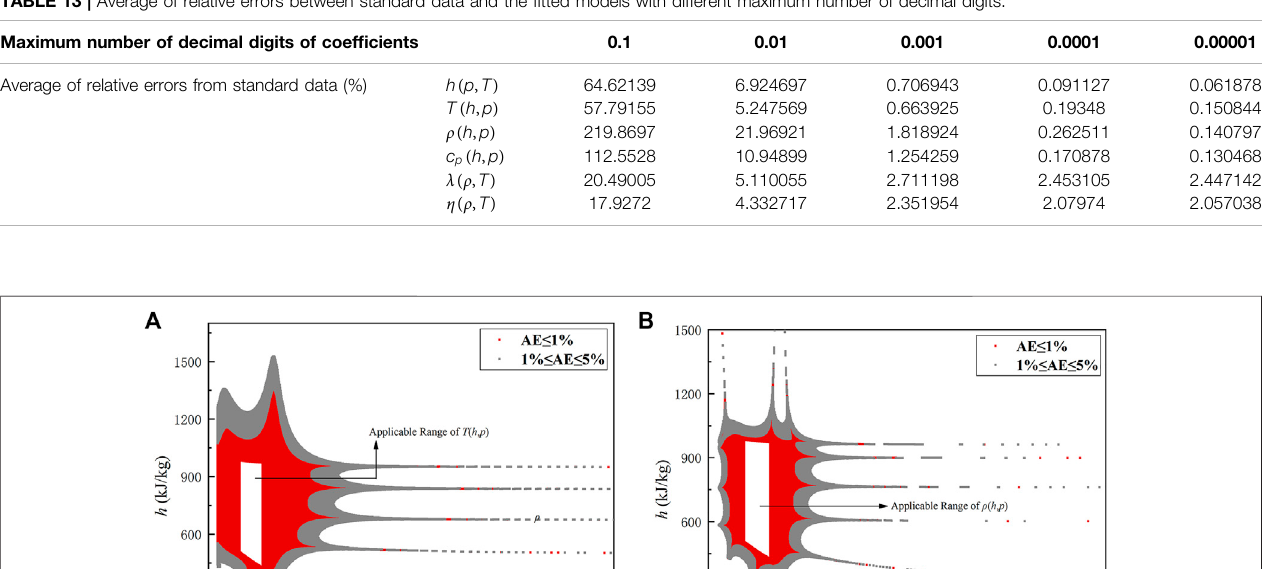
Frontiers in Energy Research |